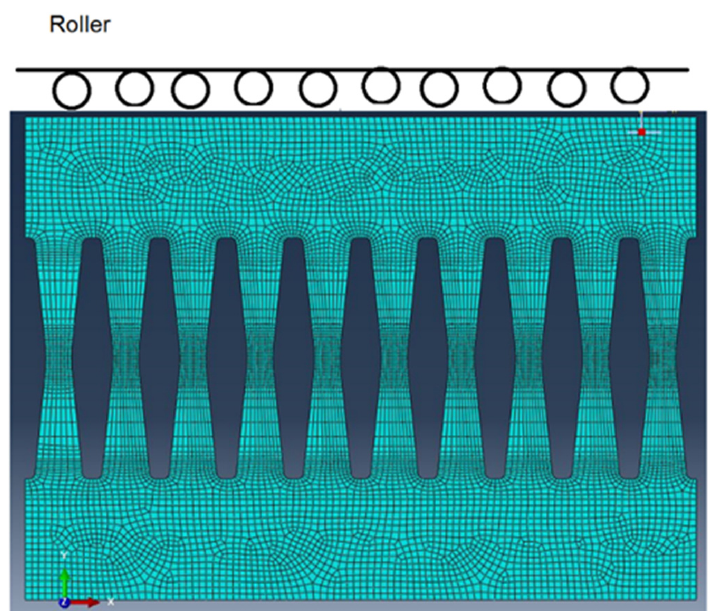
Figure 7. Schematic geometrical properties of a typically curved metal damper.